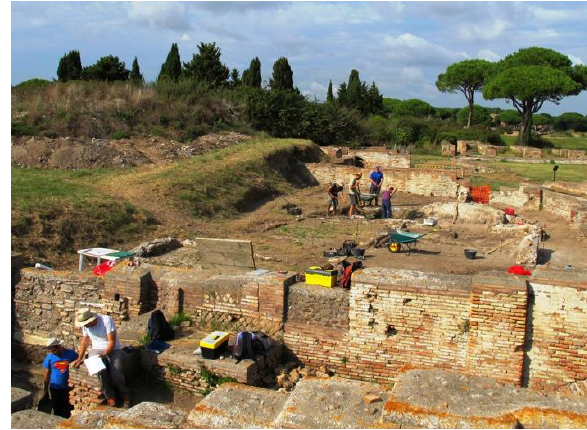
Fig. 1. Excavation Campaign 2014, Ostia Antica,